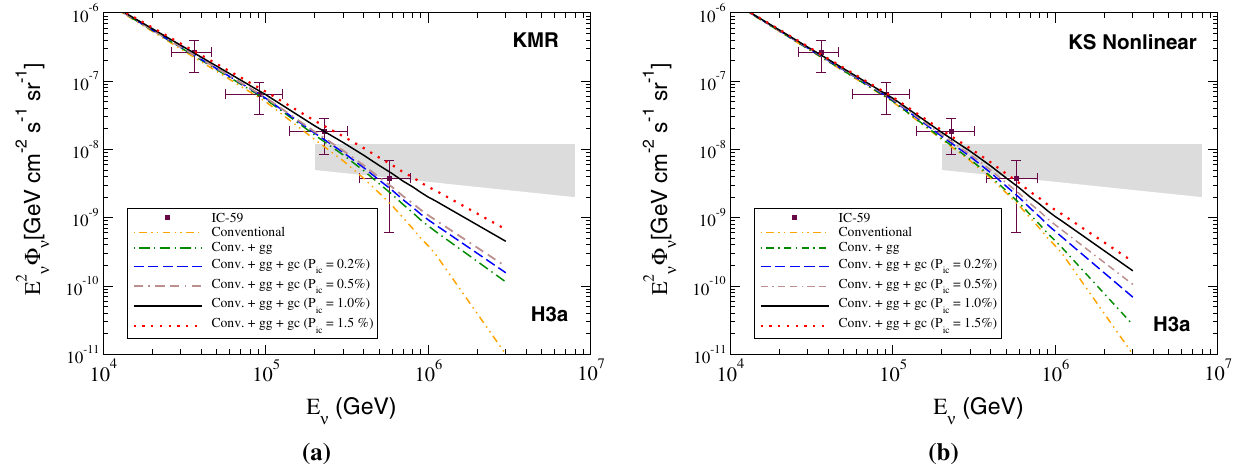
Fig. 9 Comparison between our predictions and the experimental Ice- Cubedata[2]fortheatmospheric ν μ fluxfor a KMRand b KSnonlinear uPDFs. The IC contribution was obtained for p t 0 = 2 GeV as discussed